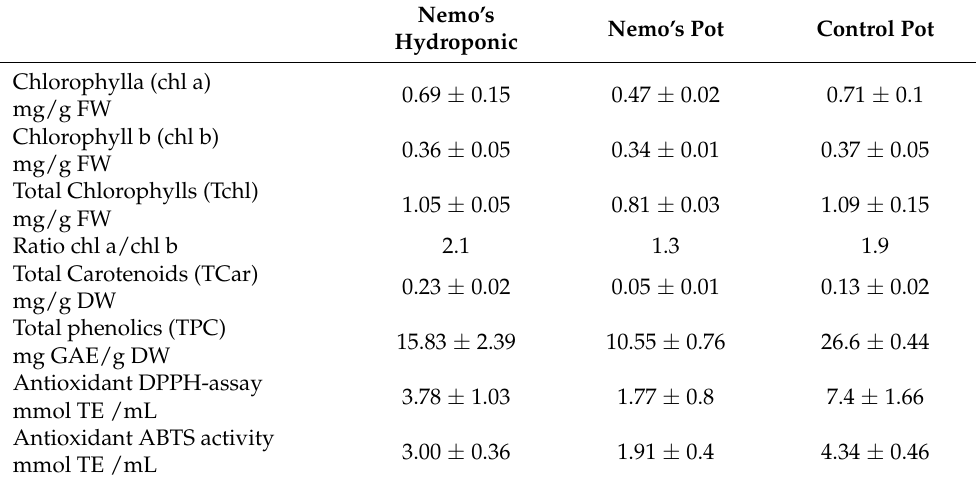
Table 1. Determination of metabolites in Stevia rebaudiana leaves collected from the Nemo’s Garden ® and from the control plants grown in terrestrial aerial condition. The data are presented as means ± standard error (SE, n = 3). Abbreviations: DW = dry weight; GAE—gallic acid equiv- alents; TE = Trolox